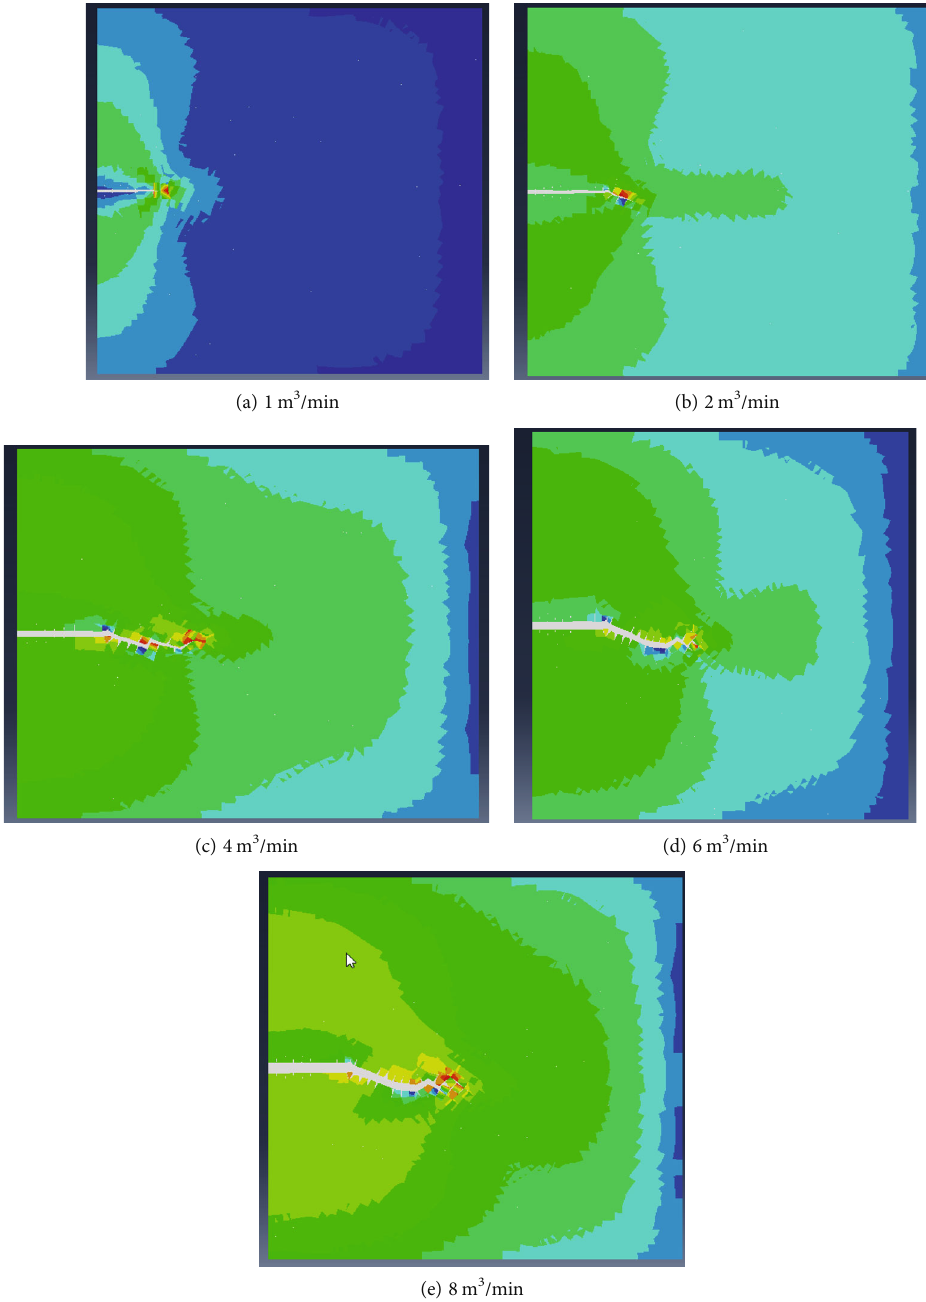
° and pump rates of 1-8 m 3